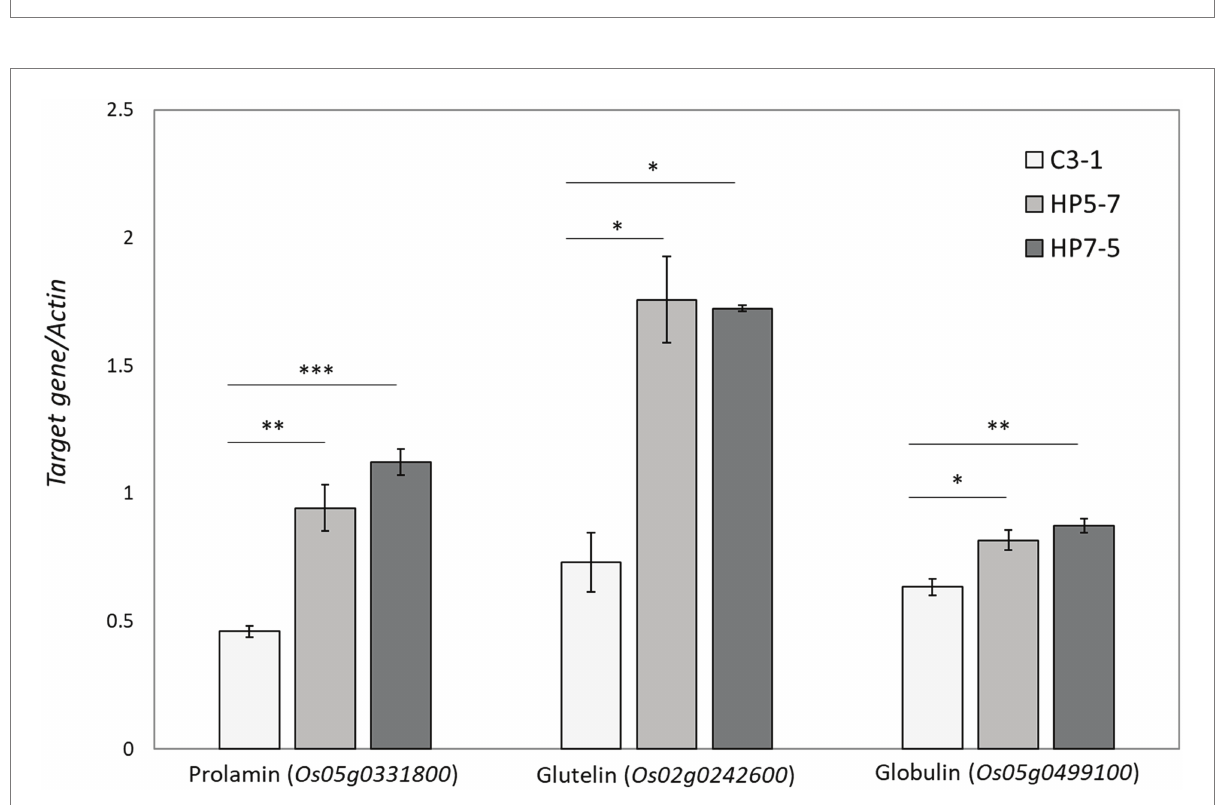
FIGURE 4 Expression levels of the genes encoding glutelin, prolamin, and globulin, based on the RNA-seq results. The log2[fold-change] value was calculated by comparison with the expression levels of C3-1 (the control).